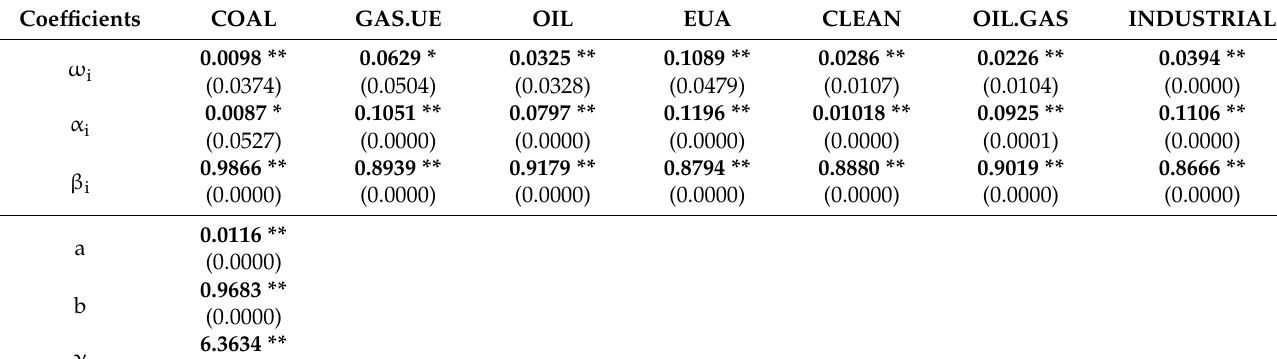
Table 4. Estimated coefficients of the DCC(1,1)-GARCH(1,1) model with multivariate Student t distribution. The significant coefficients are in